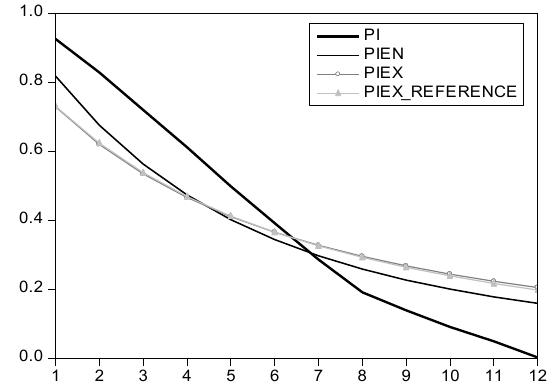
Autocorrelation function of the inflation of the real data and analog